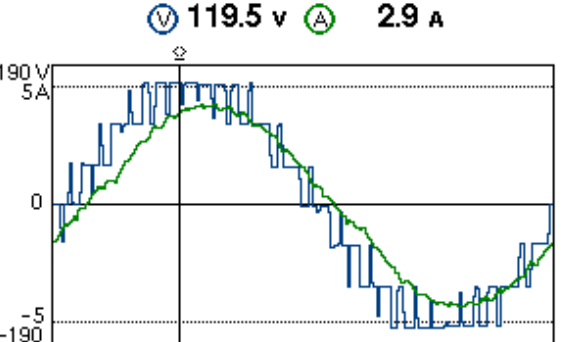
Figure 8. Voltage and current waveform of MPUC inverter with RMS calculation for 120 V system.